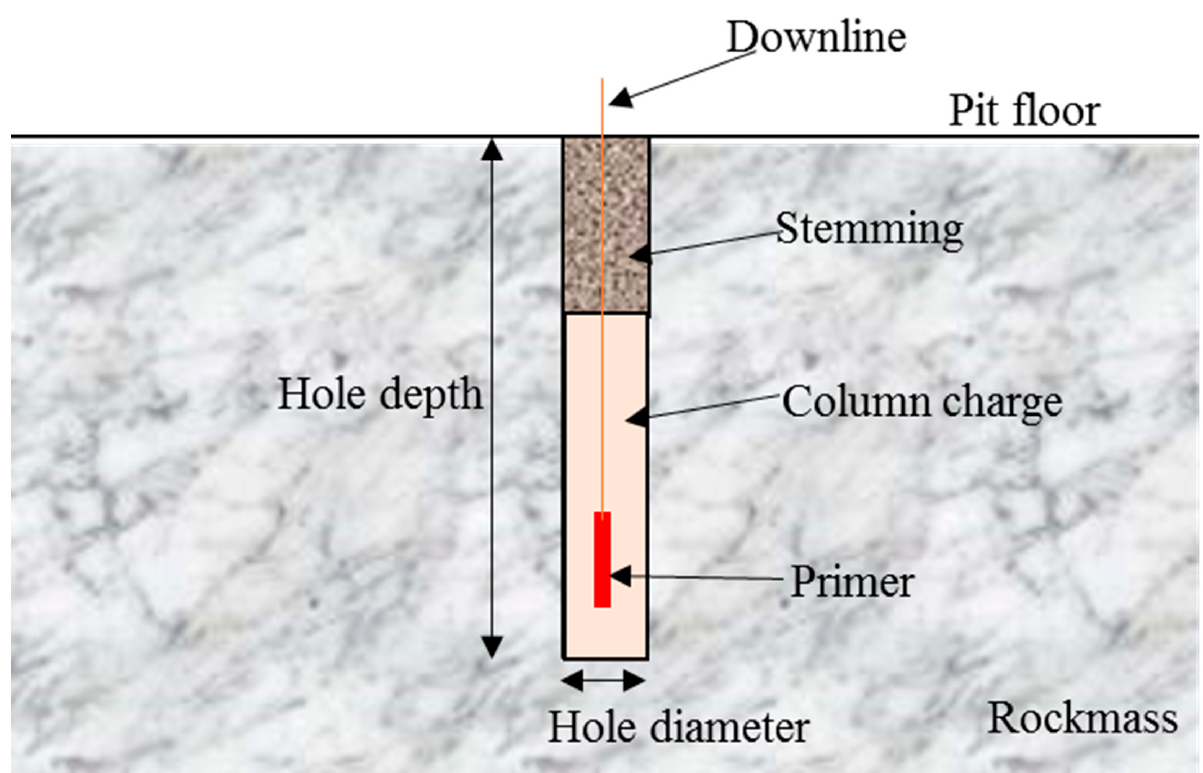
Figure 5. Schematic diagram of a charged blasthole.